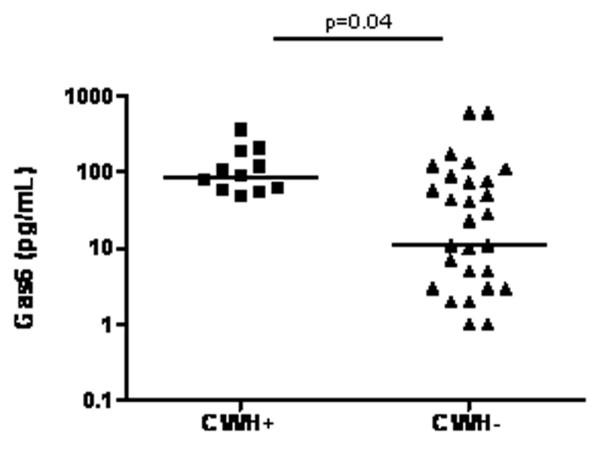
Plasma Gas6 concentrations according to need for CVVH. The two groups were compared using the Mann-Whitney U test. CVVH, continuous venovenous haemofiltration; Gas6, growth arrest-specific gene 6 product.